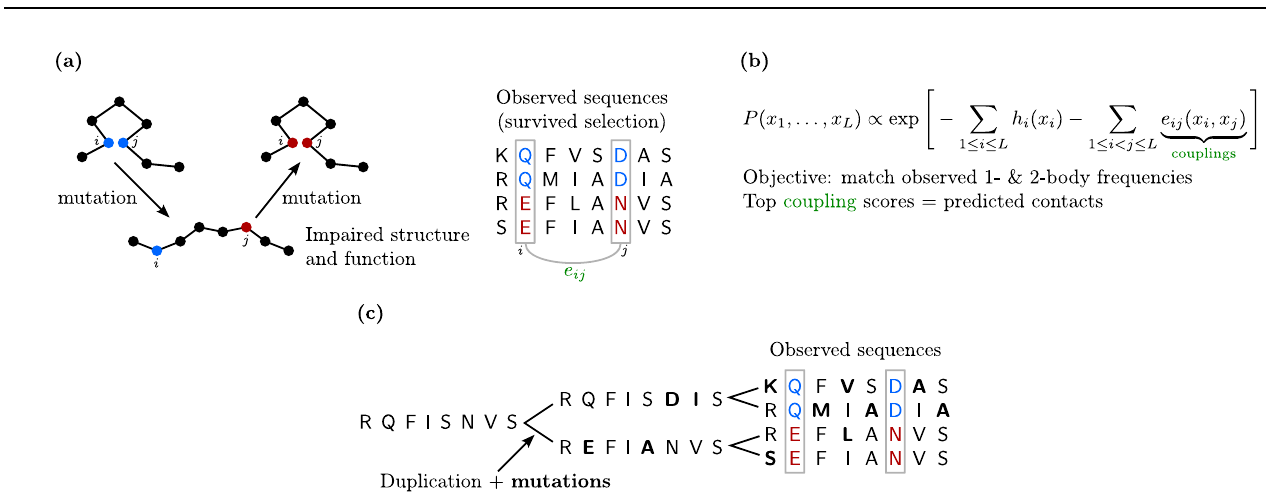
Fig. 5 | Correlations from coevolution and from phylogeny in MSAs. a Natural selectiononstructureandfunctionleadstocorrelationsbetweenresiduepositions in MSAs (coevolution). b Potts models, also known as DCA, aim to capture these